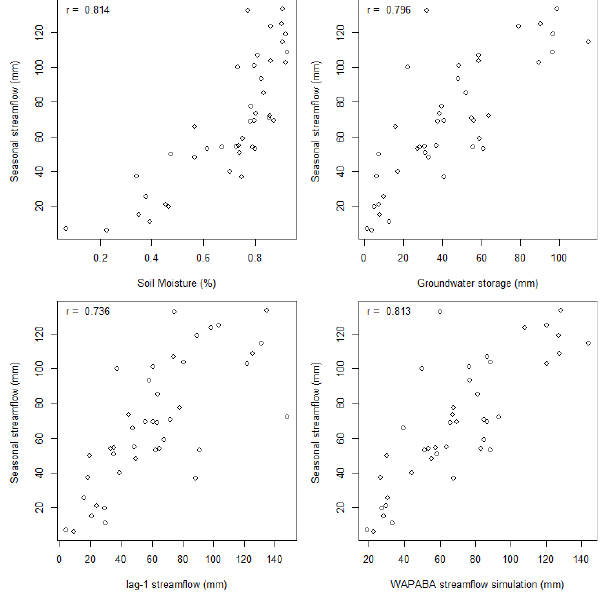
Fig. 14. The relationship between November-December-January streamflow totals and the WAPABA state variables at the end of October. October streamflow and WAPABA simulations for November-December-January for Kiewa River inflows into the Murray River (Pearson correlation coefficients shown in top left corner of each